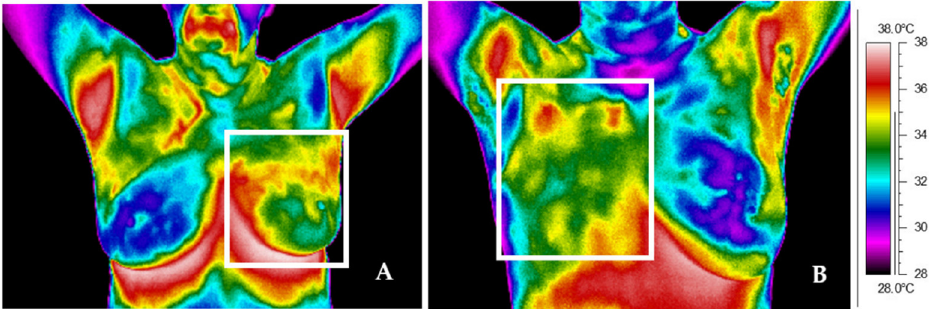
Figure 1. Thermal image of representative patient after surgery ( A ) and mastectomy ( B ) taken up to 1 year after the end of radiotherapy treatment.